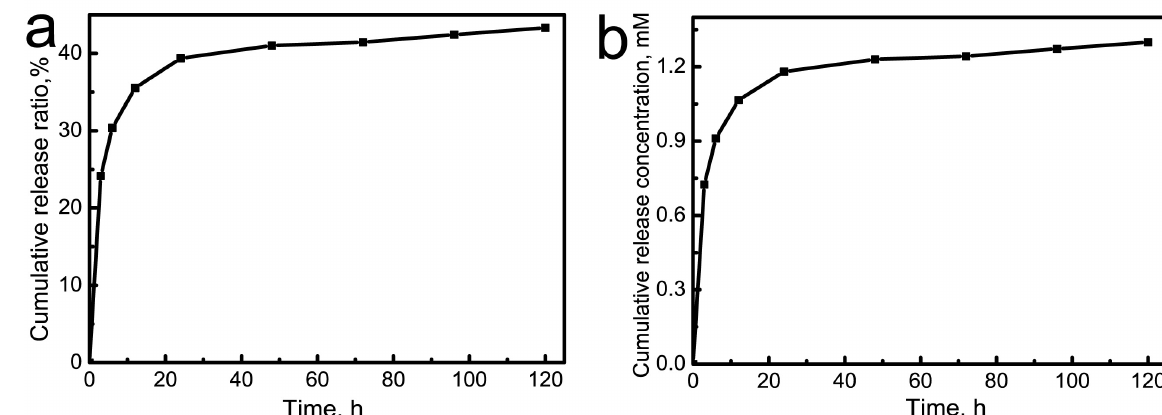
Figure 3: In vitro Yb 3+ release profiles from the Yb-CS hydrogels: (i) cumulative release concentration; (j) cumulative release ratio